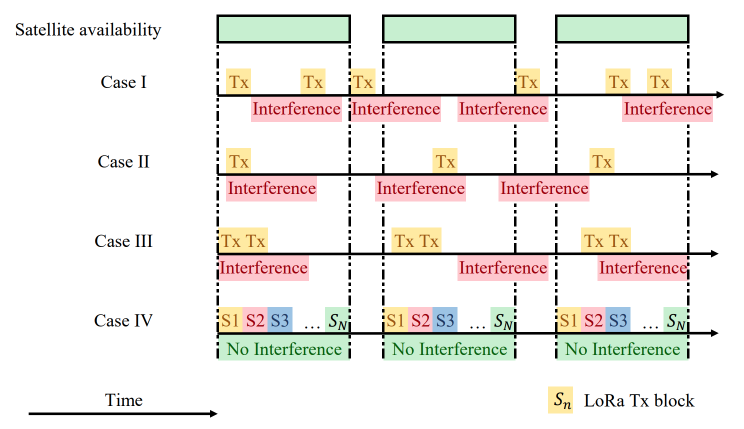
Figure 9. Illustration of the different IoT-over-Satellite uplink access models that are considered in this